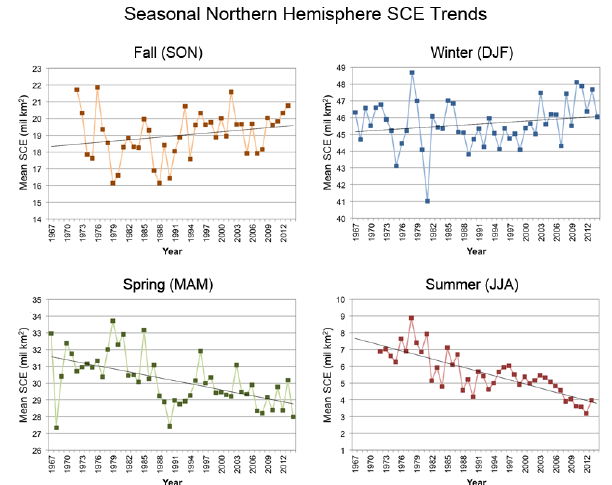
Figure 3. Seasonal SCE areas and linear least squares trends for the Northern Hemisphere in millions of square kilometres. Each season is calculated using 3-month means. Summer and fall are calculated from June 1972 onwards, due to missing months in the years 1968– 1969 and 1971. No winter or spring months are